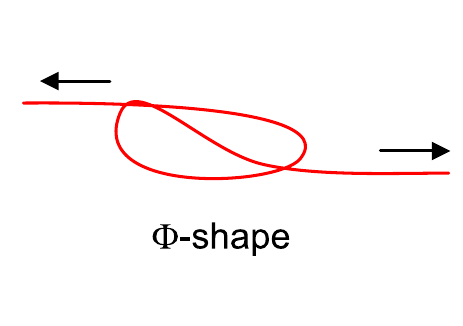
Figure 1. Schematic of the proposed sensor.